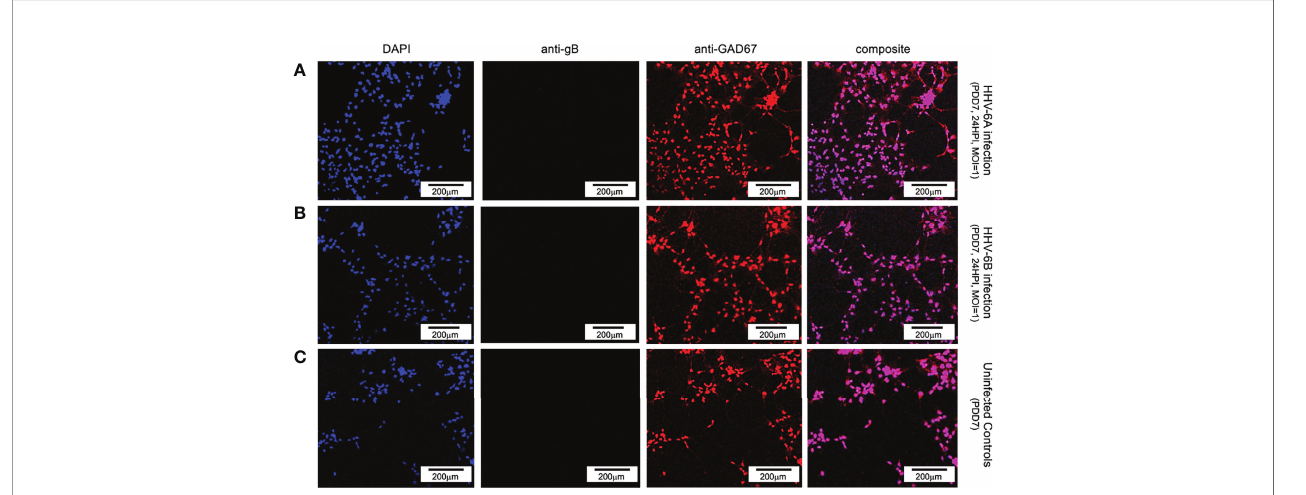
FIGURE 8 | Fluorescence microscopy images of dHNSC treated with immuno fl uorescent antibodies and a fl uoro-dye (DAPI) at PDD7: GABAergic neurons. GAD67- positive dHNSCs at PDD7 (2HPI, MOI=1) shown (left to right) by DAPI dye and anti-GAD67 immuno fl uorescence (with composites) indicate that gB (green) immuno fl uorescence does not colocalize with GAD67 (red) in DAPI stained (blue) cells for both HHV-6A (row A ) and HHV-6B (row B ) infected cultures, suggesting GABAergic neurons are not susceptible to either virus. No gB signal (green) is detected in uninfected controls (row C ). (Results were consistent across 6 replicates). [Scale bar = 200 micron].